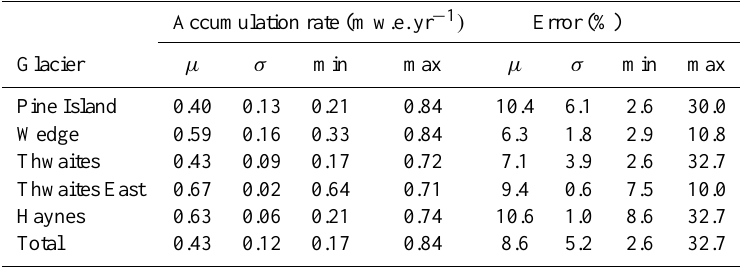
Table 2. Catchment average ( µ) , standard deviation ( σ ), minimum, and maximum gridded accumulation rates and errors. Accumulation rate (mw.e.yr − 1 ) Error (%) Glacier µ σ min max µ σ min max Pine Island 0.40